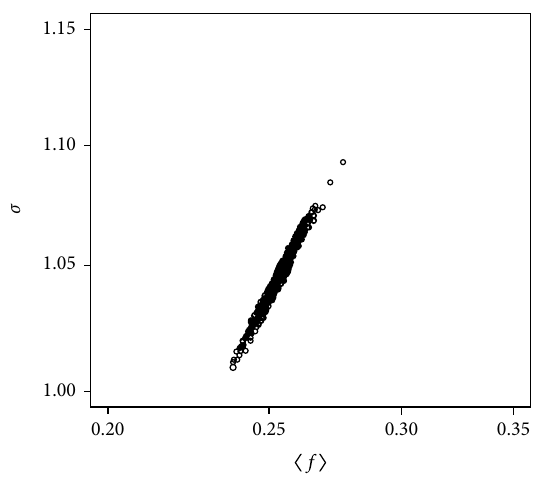
Figure 5: Relationship between the flux and the fluctuation function for the multi-state NS model, showing data for 100,000 time steps. Here, the vehicle density is 0.40, 𝑝 = 0.01 , v max = 5 , threshold_slow = 5, and threshold_acceleration =